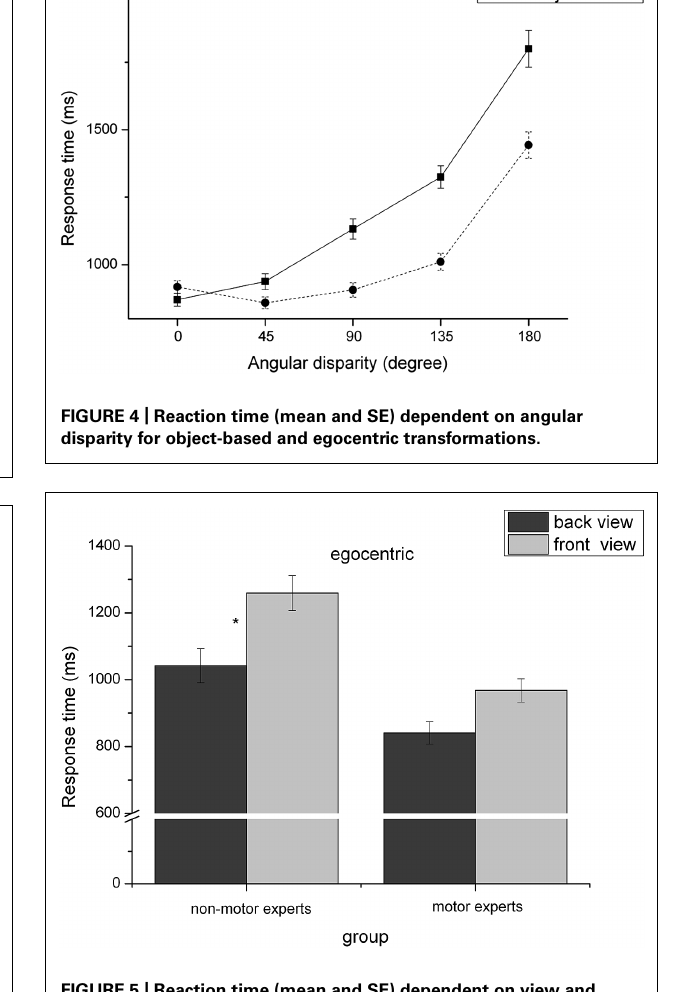
size for the factor “view” in egocentric transformations was much stronger with r = 0.96 ( d = 0.62). The main effect of “group” indicates that motor-experts ( M = 942.0 ms, SD = 41.1)